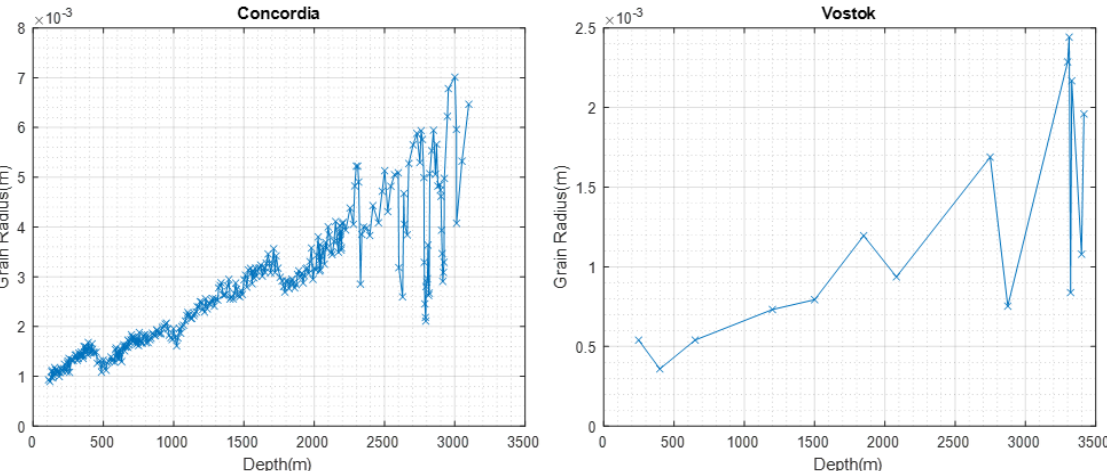
Figure 2. In situ measurements of ice grain size versus depth at ( left ) Concordia and ( right ) Vostok Stations. Data have been obtained from [21,22].